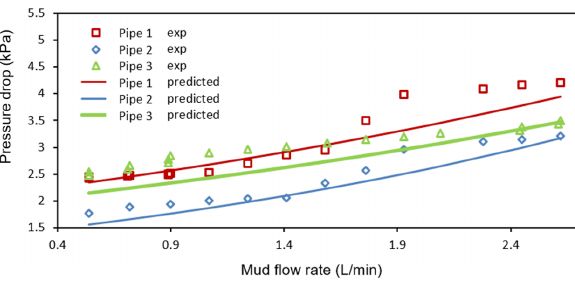
Figure 8: Comparison between the experimental and predicted pressure drops in the pipes 1, 2, and 3 vs. mud flow rate.